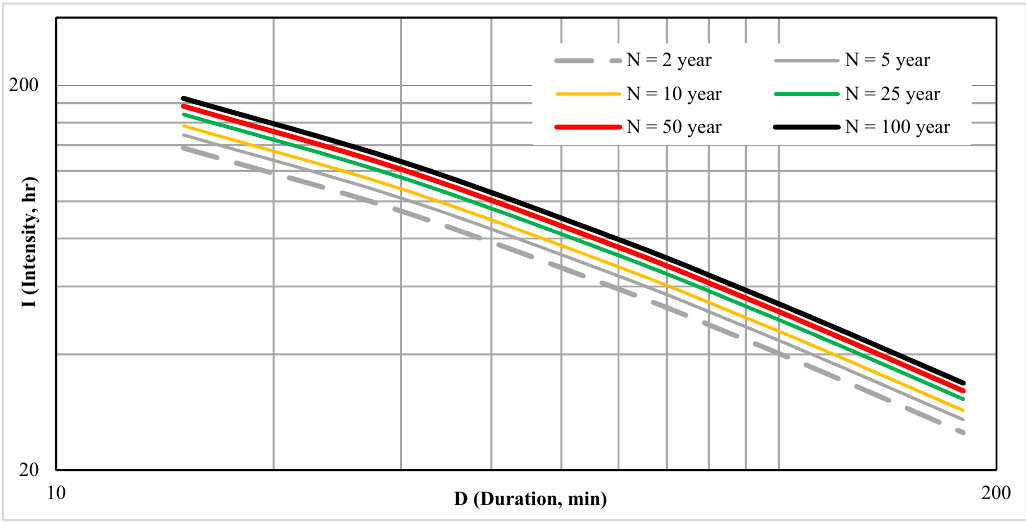
Figure 7. Development of IDF rainfall curve based on the Viet Nam standard (TCVN 7957:2008, using the neighborhood parameter, Ca Mau province).